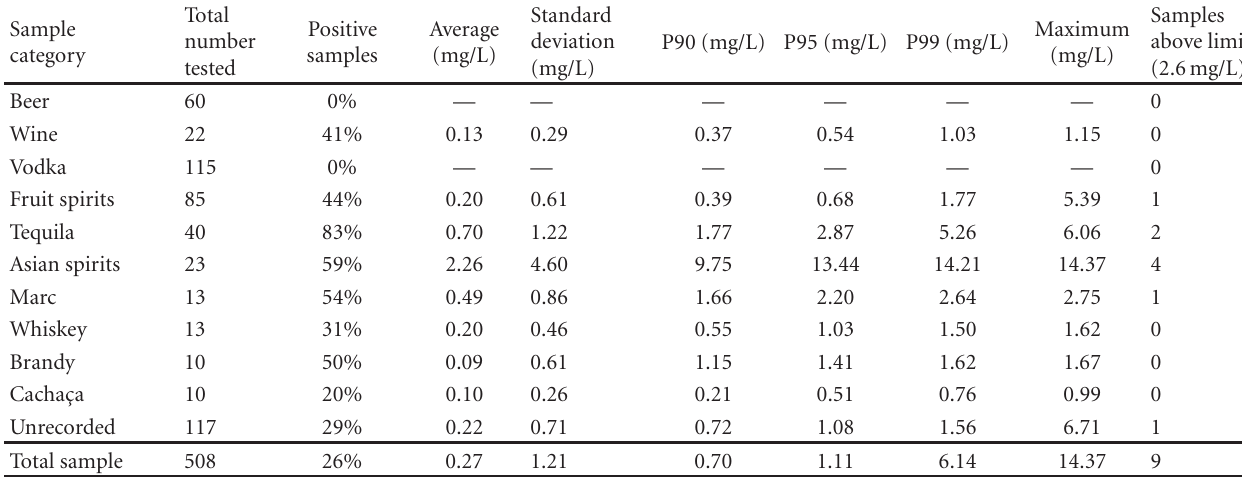
Table 1: Results of the quantitative determination using chromotropic